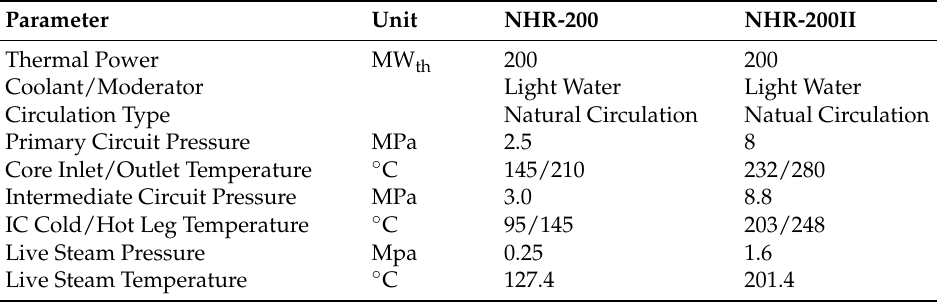
Table 1. Main design parameters of NHR-200 and NHR-200II.